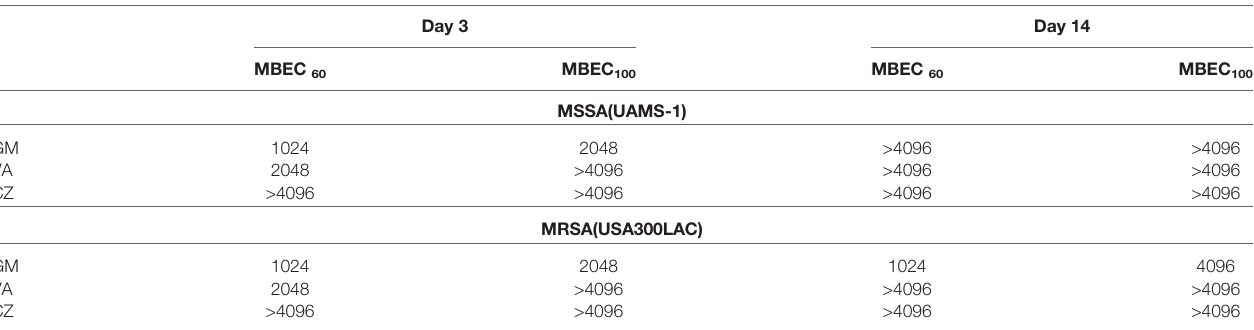
TABLE 3 | MBEC on residual bacteria in in vivo bio fi lm on a screw after VSVM ( in vivo implant